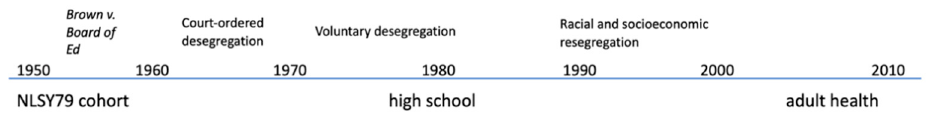
Figure 1. Educational historical context as related to the present study.